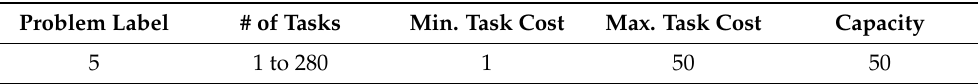
Table 3. Problem conditions in our 5th experiment. Task costs are sampled from the uniform distribution over the interval [Min. task cost, Max. task cost].